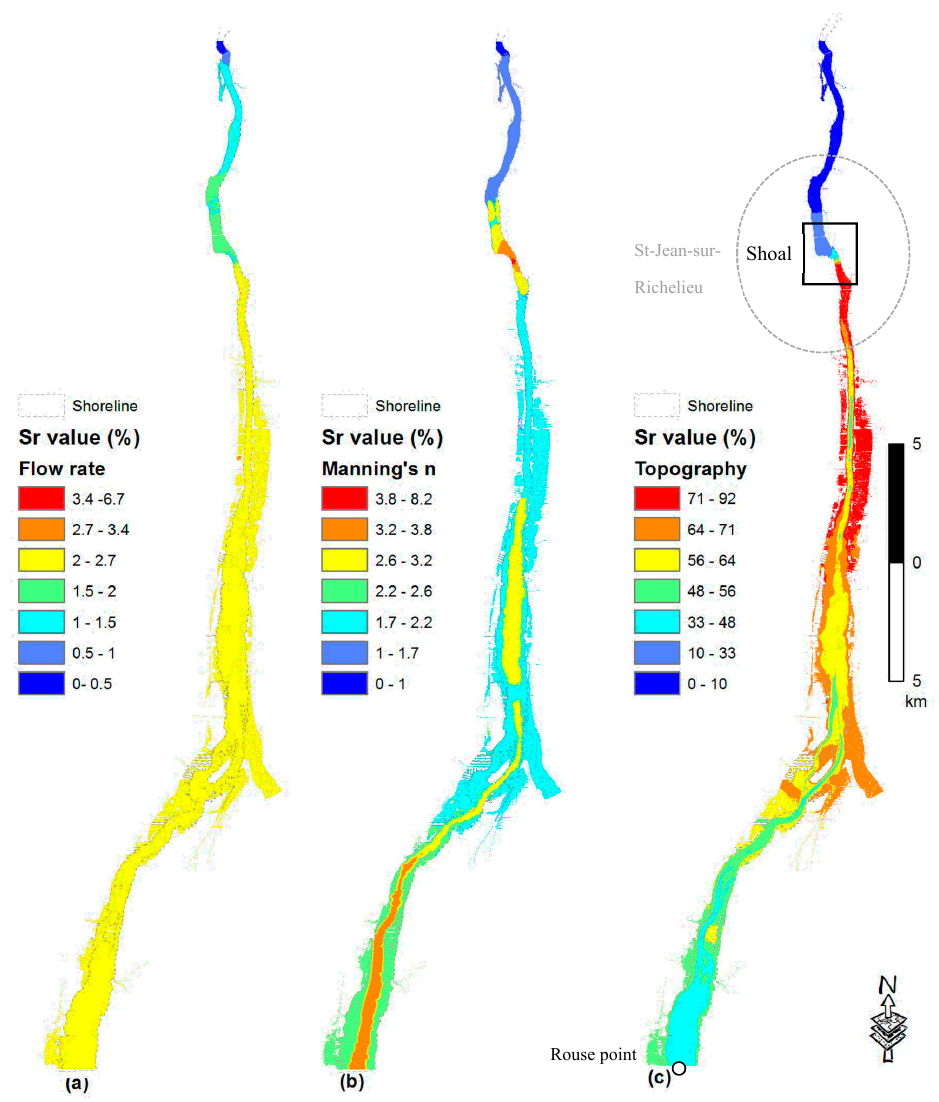
Figure 5. Sensitivity of the simulated flow depths for each of the three input variables, ( a ) flow rate Sr ( X 1 ) , ( b ) Manning’s n coe ffi cient Sr ( X 2 ) , and ( c ) topography Sr ( X 3 ) , for nominal flow rate of 759 m 3